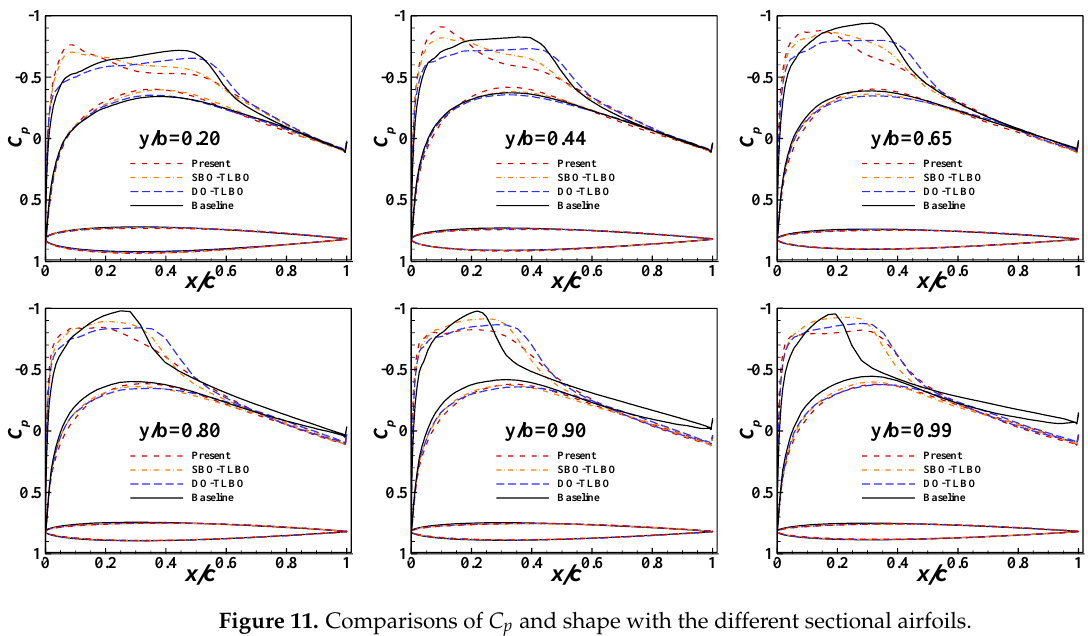
Figure 10. Convergence process drag coefficient ( C d ) by proposed, SBO, and DO methods.